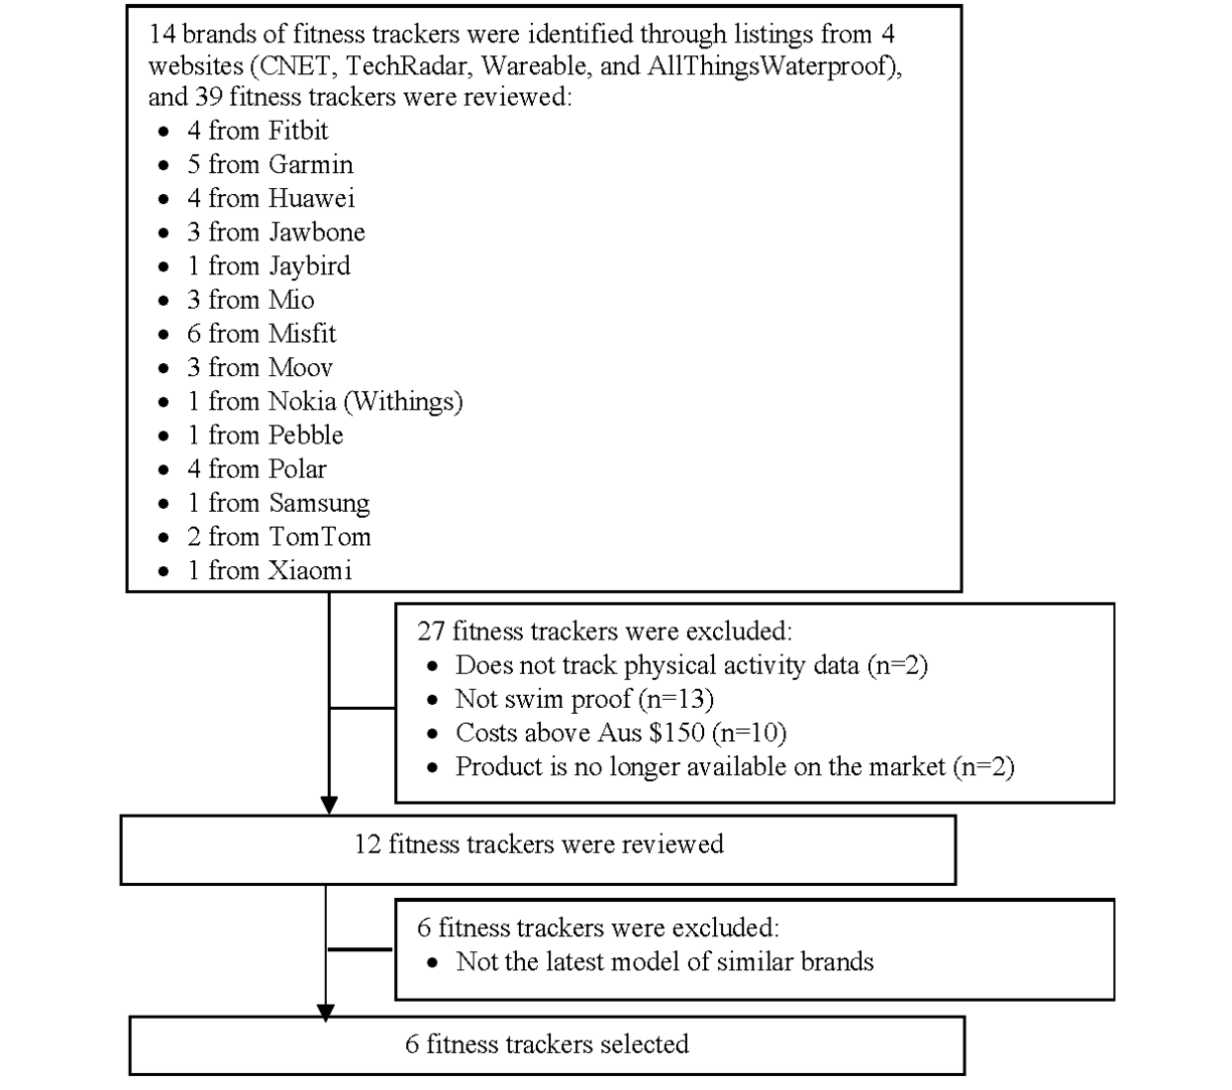
Figure 1. Flow diagram describing the fitness tracker search and selection process.